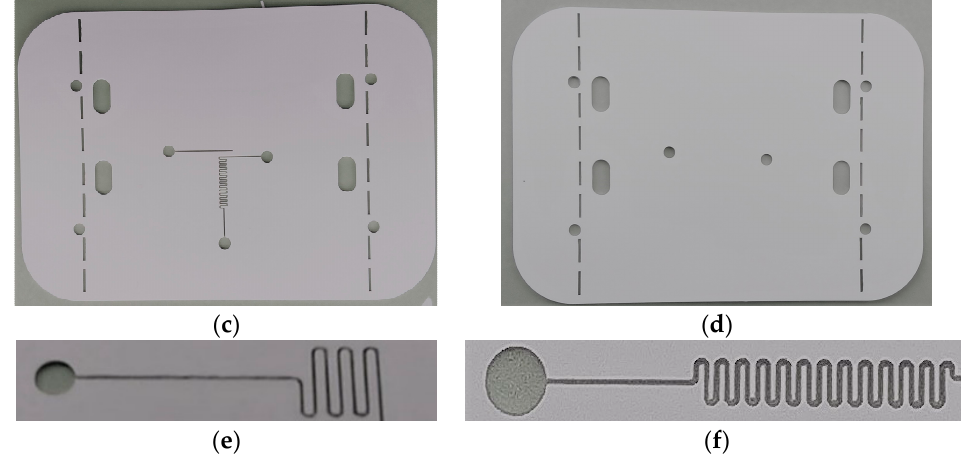
Figure 6. Green tapes after the cutting process: ( a ) Layer 1; ( b ) Layer 2; ( c ) Layer 4; ( d ) Layer 5; ( e ) Enlarged detail of layer 2; ( f ) Enlarged detail of layer 4.